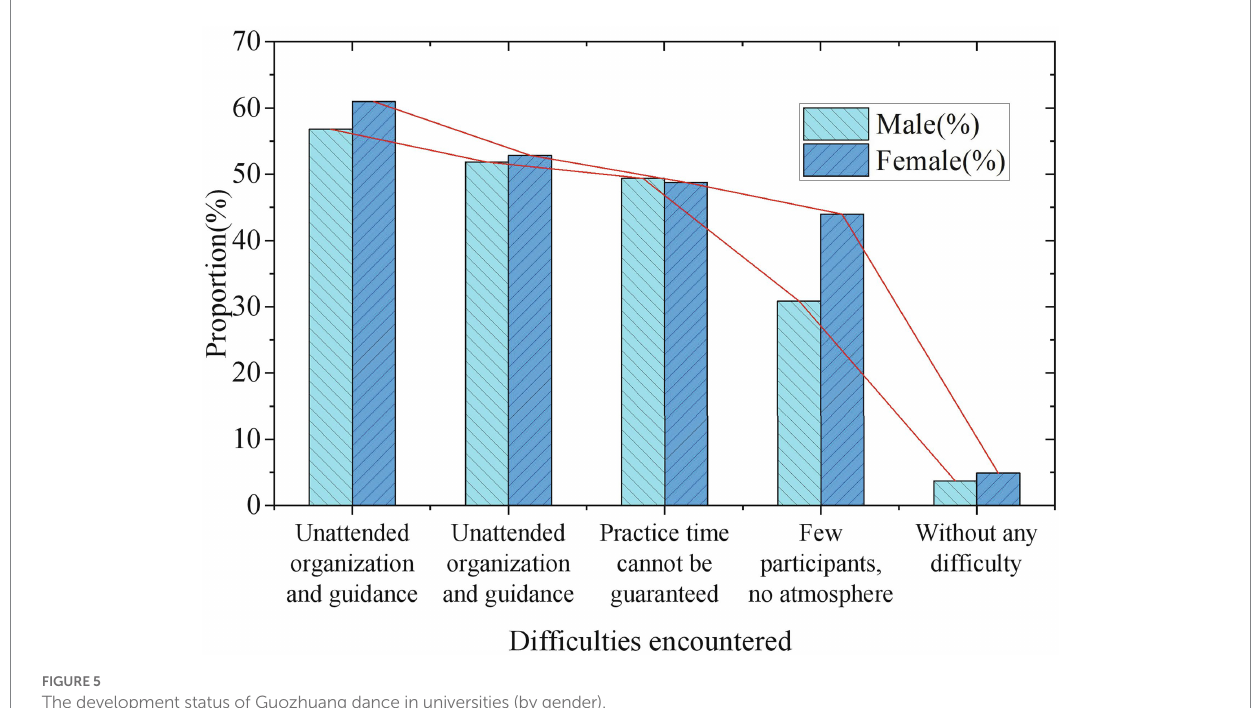
FIGURE 5 The development status of Guozhuang dance in universities (by gender).